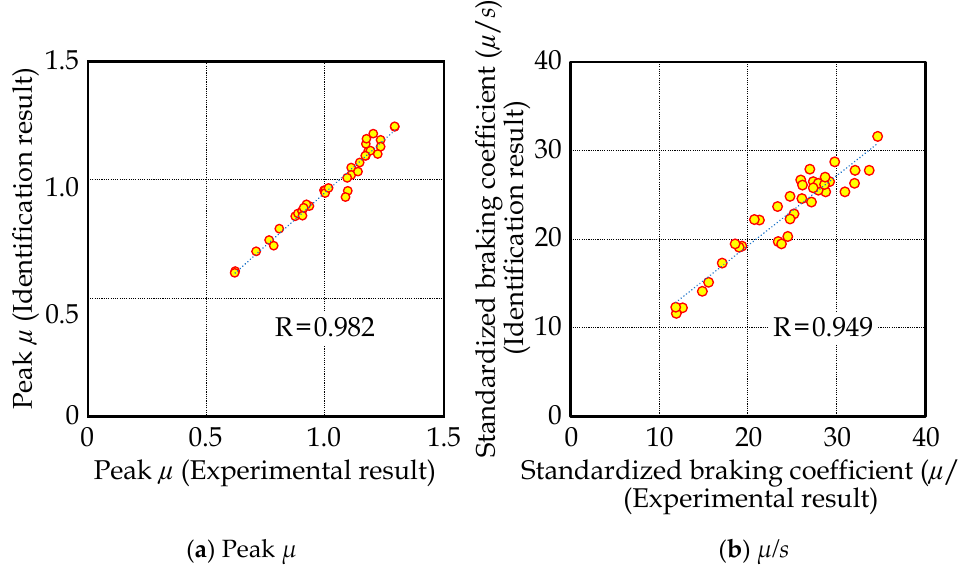
Figure 3. Comparison between experimental results and identification results.